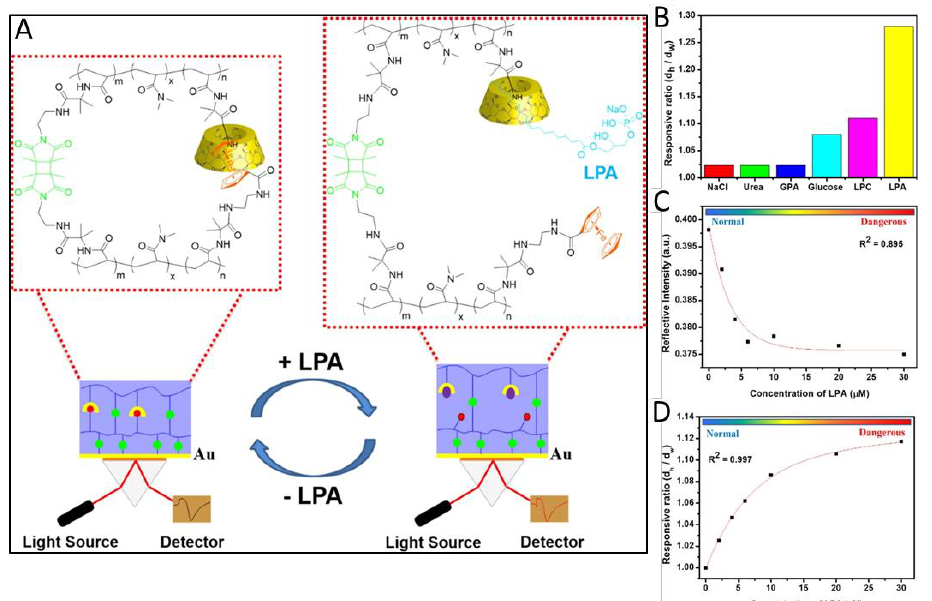
Figure 5. ( A ) Schematic illustration of the SPR-OWS sensor based on the dually crosslinked supramolecular hydrogel toward the specific detection of LPA in mimicked plasma conditions. ( B ) Responsive ratio (where d h is the layer thickness of the hydrogel in diverse components and dw is the layer thickness of the hydrogel in water) of the DCSH in the presence of major blood plasma components. NaCl (100 mM), urea (5 mM), glucose (3 mM), GPA (10 µ M), LPC (10 µ M), and LPA (50 µ M). ( C ) Plot of reflected intensity against the concentration of LPA in mimicked plasma from the measured SPR-OWS spectra at a certain angle of incidence of 57 and its nonlinear fitting. ( D ) Plot of the responsive ratio against the concentration of LPA from simulated parameters of SPR-OWS and its nonlinear fitting (Reprinted/adapted with permission from [59]. Copyright 2018 American Chemical